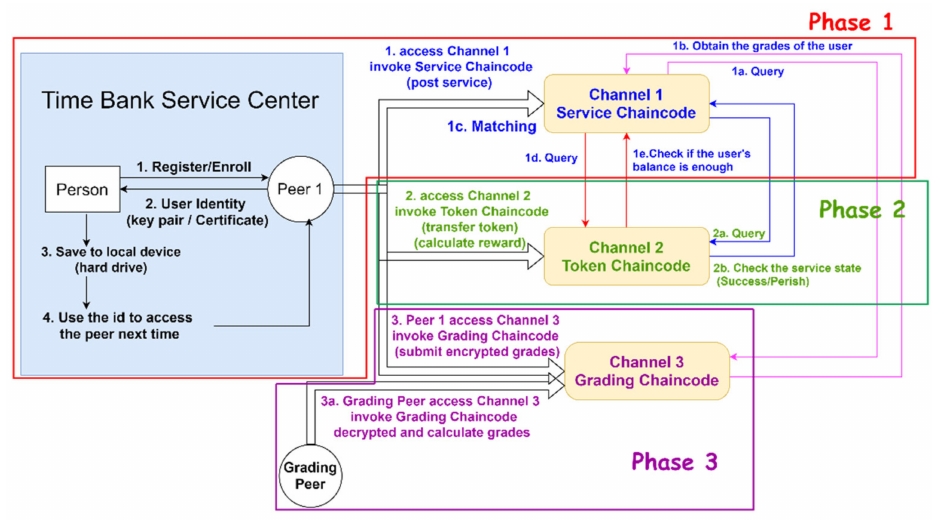
Figure 3. The information flow and processing procedures of the proposed time bank